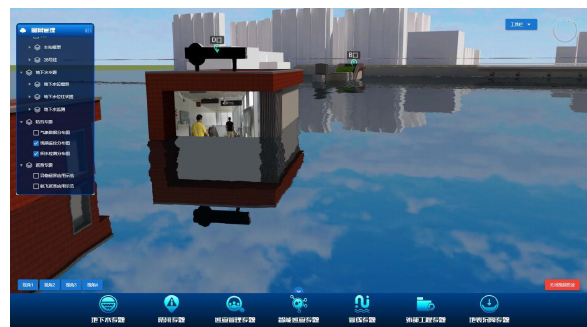
Figure 11 . Flood control intelligent scene simulation.